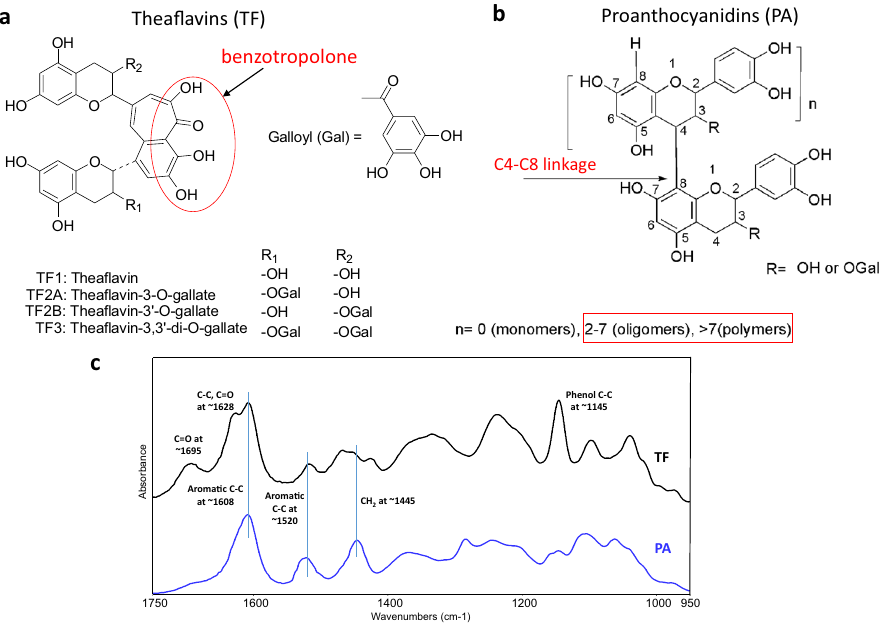
Figure 1. Schematic diagrams of molecular structures of theaflavins (TF) from black tea ( a ) and proanthocyanidins (PA) from grape seed ( b ); representative FTIR spectra of TF and PA powders ( c